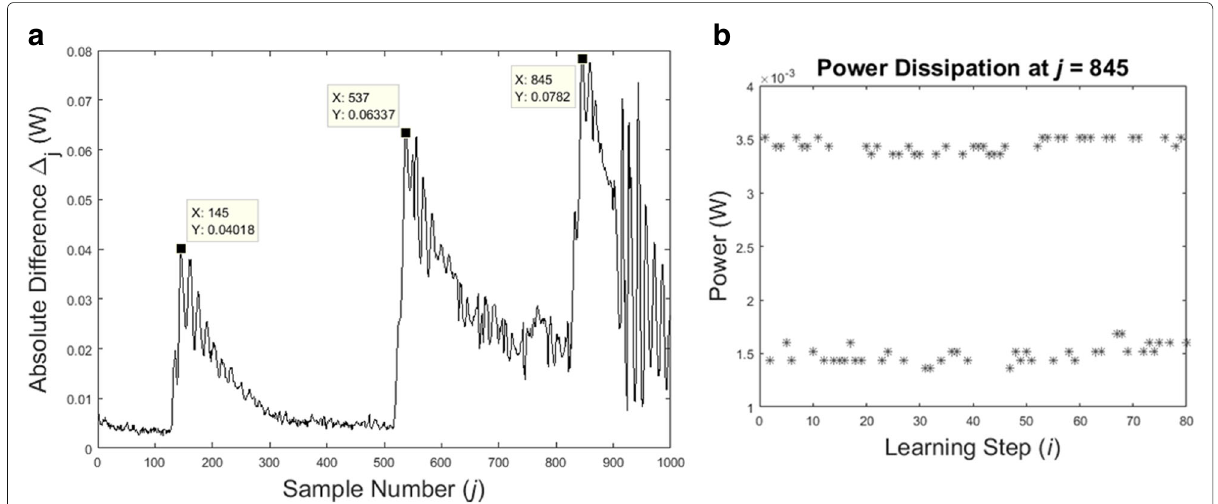
Fig. 7 Classifying POI and O m . a Absolute difference of sample and mean. Another form of a standard deviation calculation. b Recorded power at j = 845. For each learning step, a noticeable gap